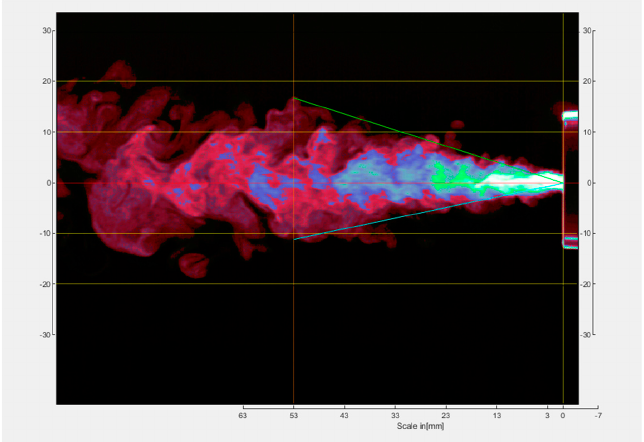
Figure 4. Measurement of geometric pattern.